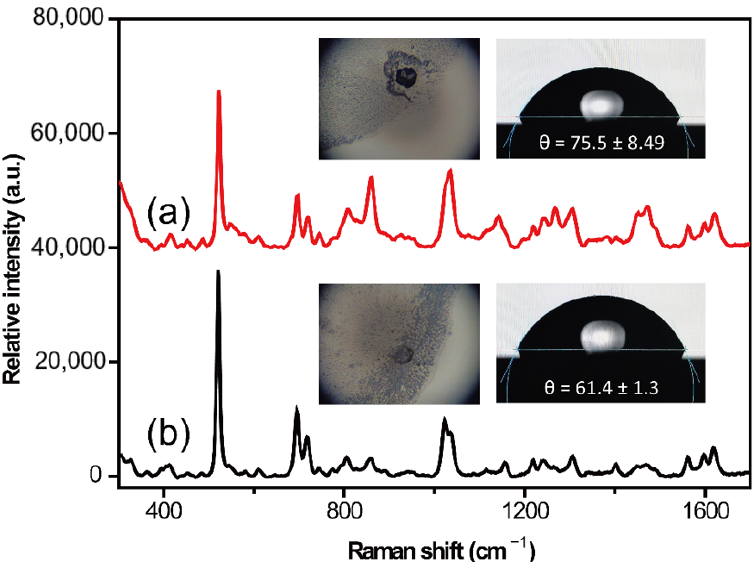
Figure 1. Carbamazepine (CBZ) (20 µ g · mL − 1 ) surface-enhanced Raman spectroscopy (SERS) spectra collected from silicon wafer treated with cleaning fluids ④ ( a ) and ⑤ ( b ). The illustrations on the left are the photomicrographs of the sample detection site, while the right inserts show the contact angle of water on the silicon wafer after treatment with the different cleaning fluids.